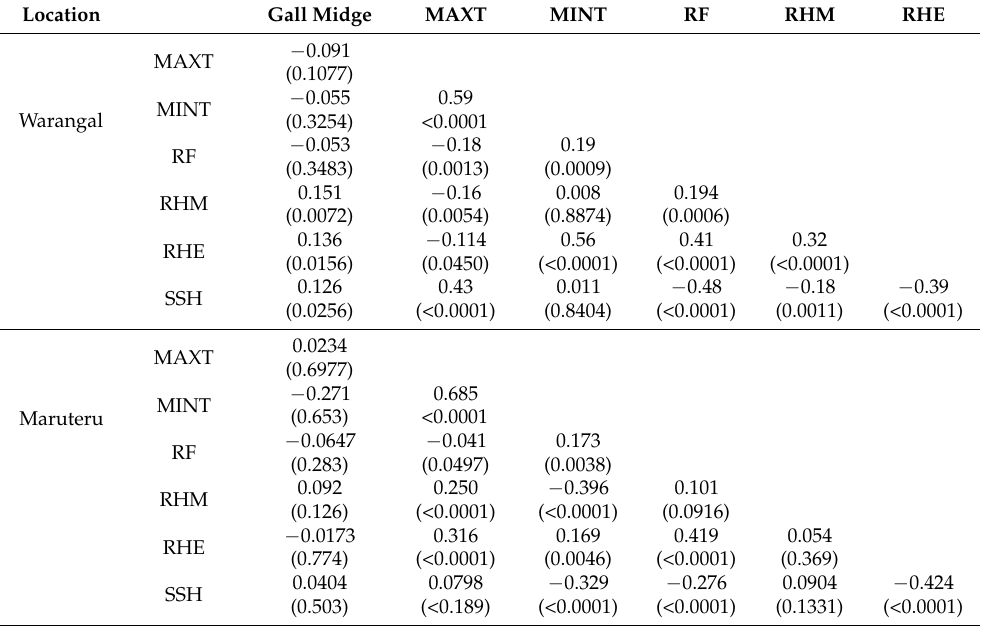
Table 2. Pearson correlation coefficients between gall midge light trapped individual collections and climatological variables at study